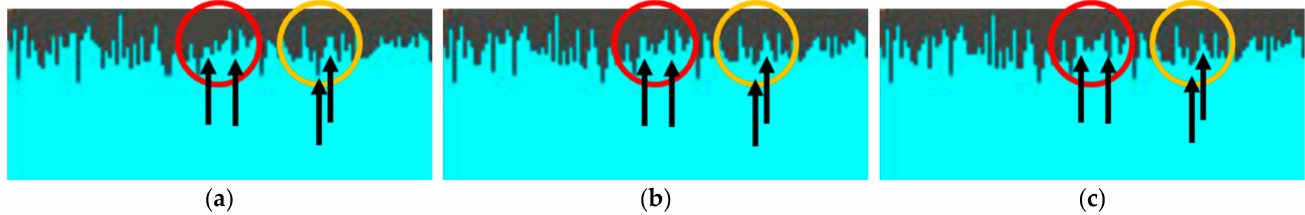
Figure 9. Raw intensity data in a part of the scanned profile. Differences of measured intensity at one pose: ( a ) Scan no. 4; ( b ) scan no. 14; ( c ) scan no. 16.